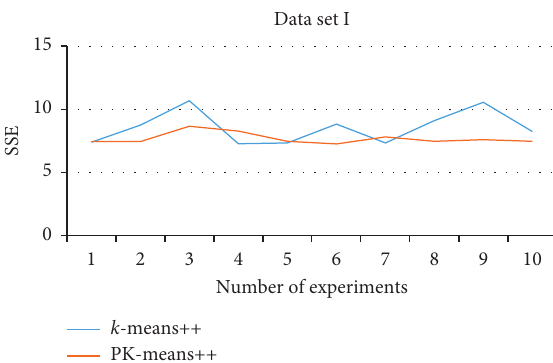
Figure 8: Comparison of the SSE on data set